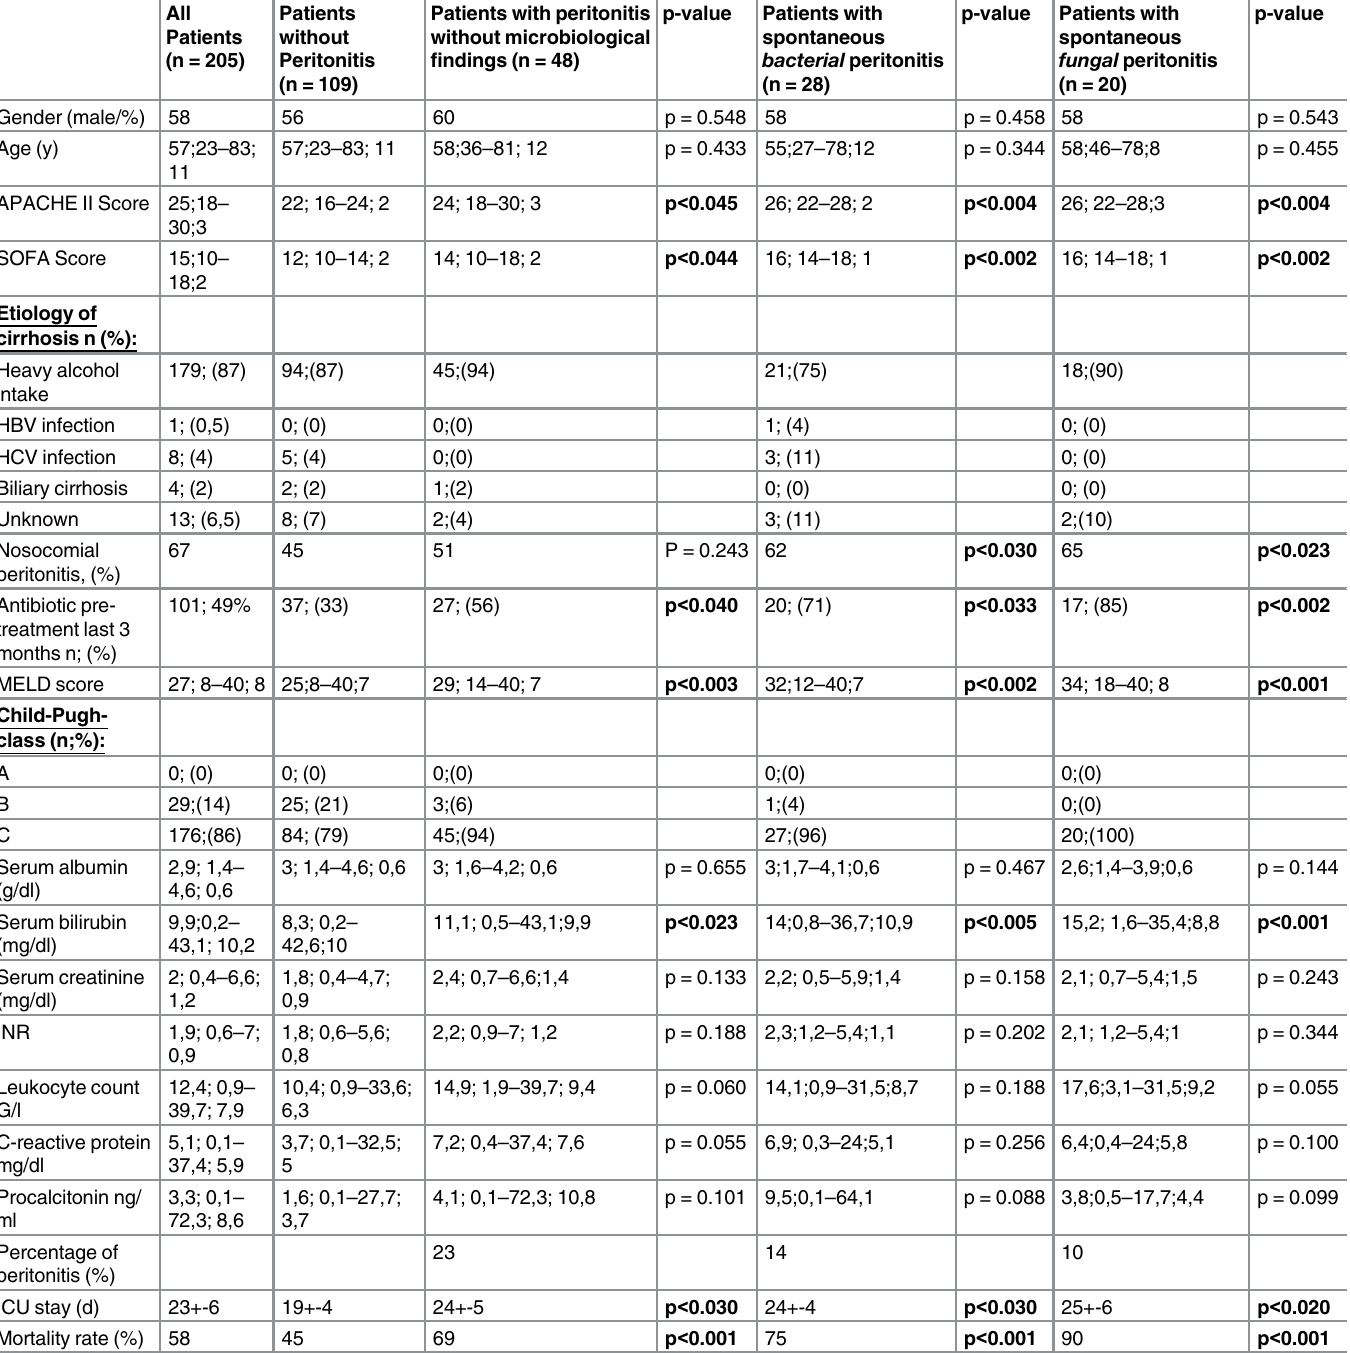
Table 1. Demographic and clinical characteristics of the patients. All